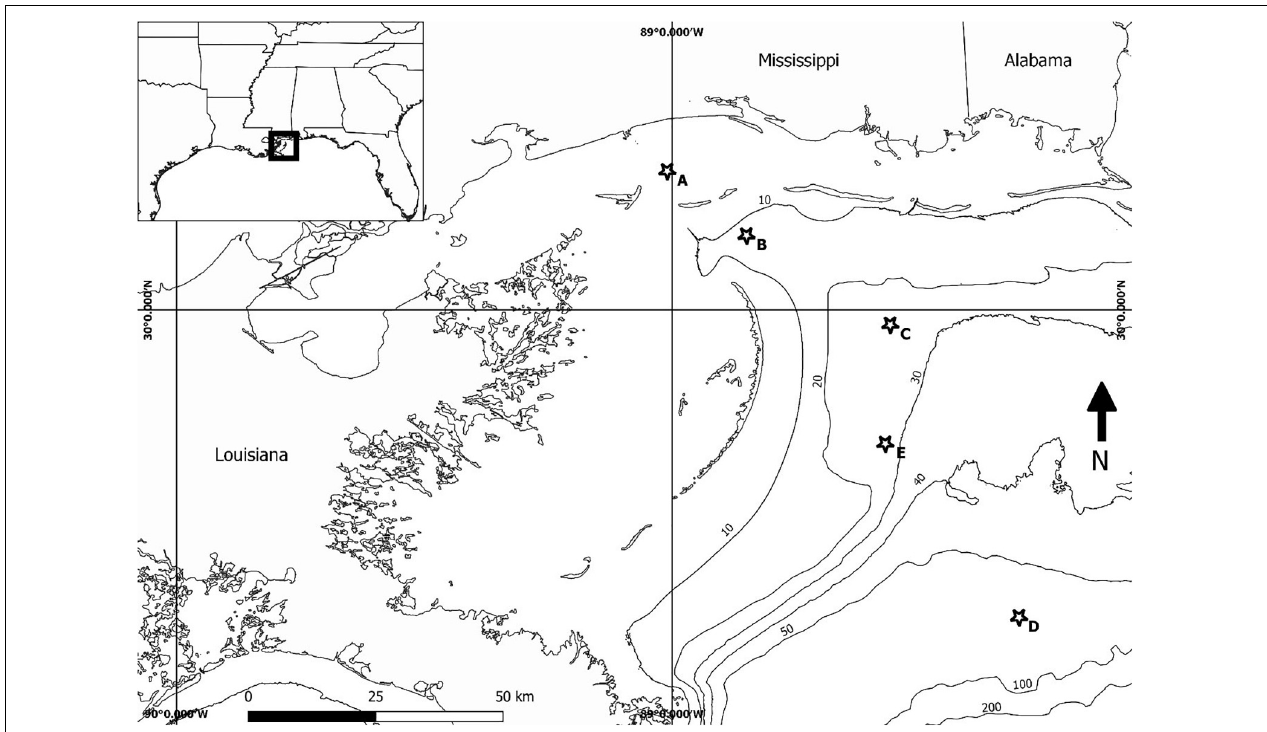
FIGURE 2 | Sea turtle carcass and wood effigy deployment locations. Deployments occurred twice a month from January to December at sites A, B, C and monthly from February–May and July at sites D and E. Depth contours are in meters.